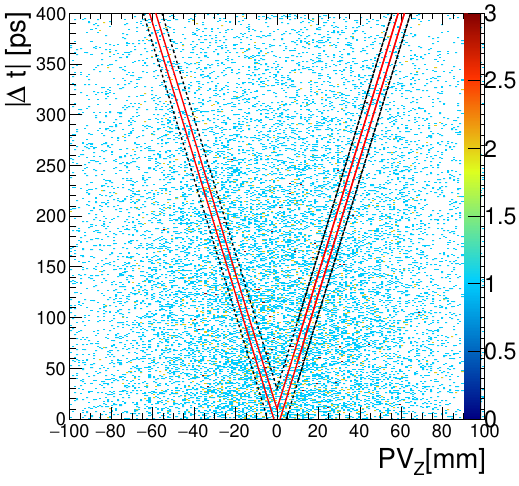
Figure 6 . Distribution of absolute time di(cid:11)erence of superimposed pile-up protons tagged in the FDs versus displacement of PV in the z -direction for inclusive W + W (cid:0) (cid:13) process. The protons are restricted to pass 0 : 008 < (cid:24) < 0 : 2 requirement. The average number of pile-up per each bunch crossing is < N PU > =30. The events between red (black dashed) lines will pass the timing requirement due to coincidence of pile-up protons with their PV position considering 10(30) ps